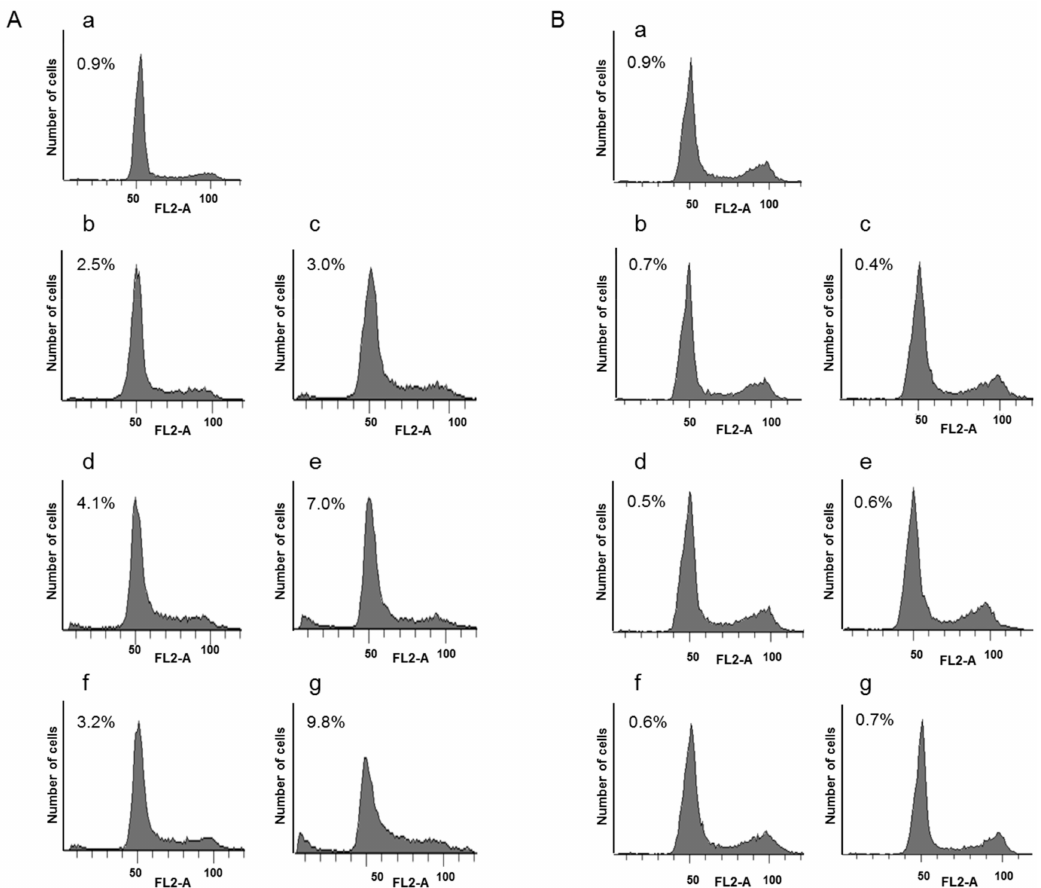
Figure 8. Antitumor activity of the PAMAM-O/Flag-apoptin polyplex in vitro. HepG2 cells ( A ) and dermal fibroblasts ( B ) were transfected with polyplexes with PAMAM and PAMAM-O dendrimers and 1 µ g of Flag or Flag-apoptin. After 48 h incubation, the cells were harvested, and the cell cycle distribution was assessed using flow cytometry after propidium iodide (PI)-staining of nuclei. The micrographs indicate ( a ) control without polymer or polyplex; ( b ) Flag; ( c ), Flag-apoptin; ( d ) PAMAM/Flag; ( e ) PAMAM/Flag-apoptin; ( f ) PAMAM-O/Flag; and ( g ) PAMAM-O/Flag-apoptin. A total of 10,000 cells were counted for DNA content measurement. Apoptosis was measured as the percentage of the total cell population with Sub-G 0 /G 1 DNA content (upper left corners of each